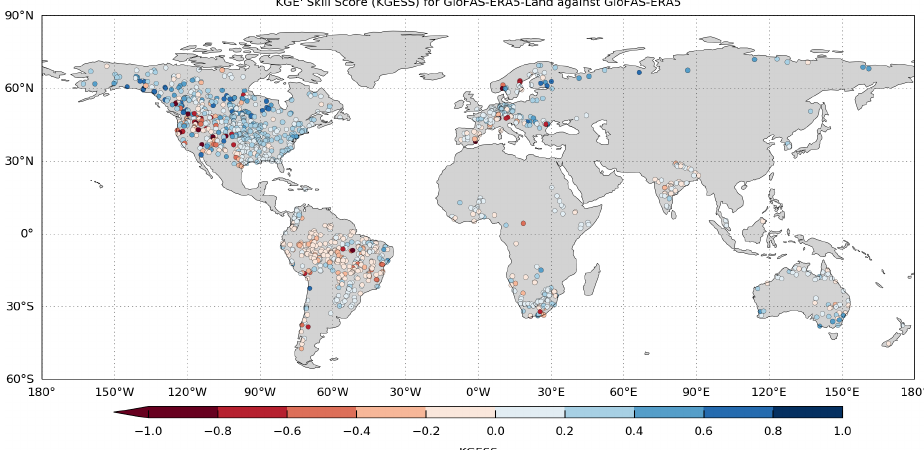
Figure 14. Modified KGESS for GloFAS-ERA5-Land river discharge reanalysis against the GloFAS-ERA5 benchmark across 1285 obser- vation stations. Optimum value of KGESS is 1. Blue (red) dots show catchments with positive (negative) skill.